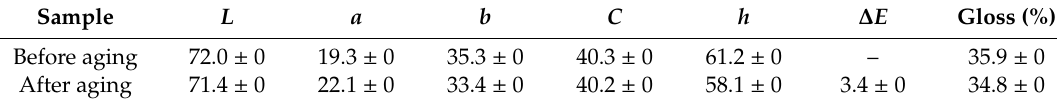
Table 10. Effect of time on the color difference of waterborne coatings.